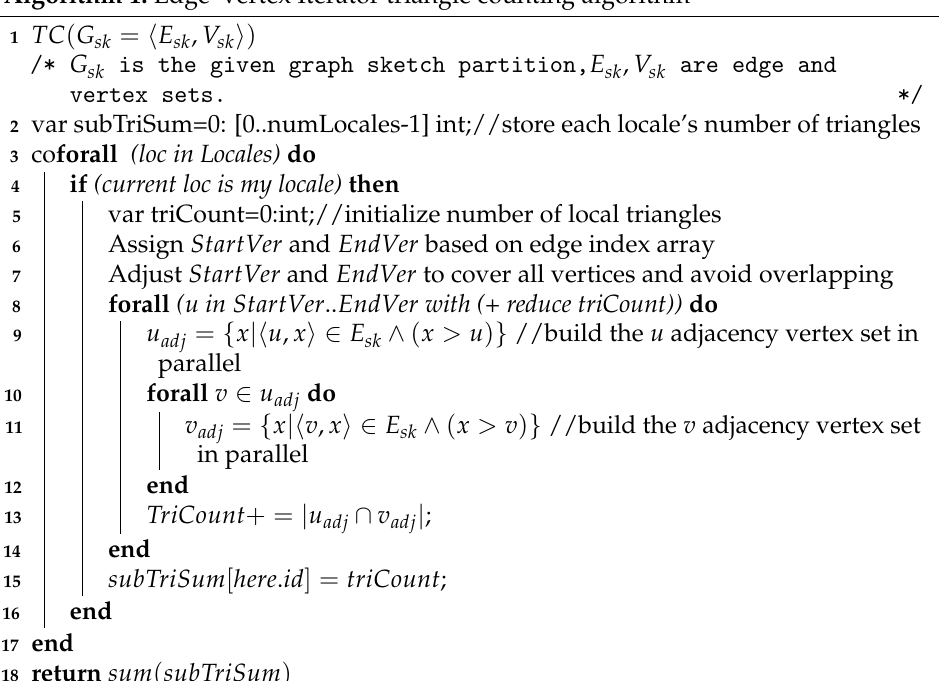
Algorithm 1: Edge–vertex Iterator triangle counting